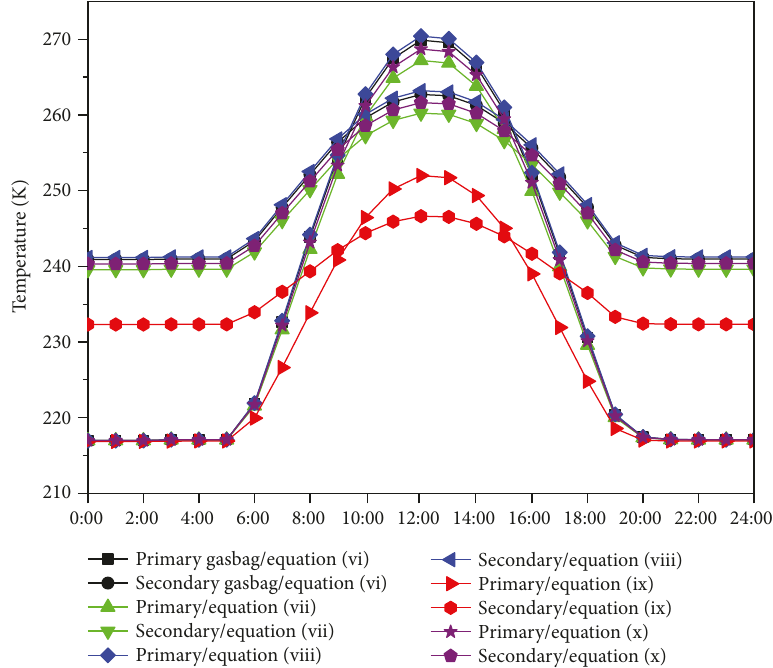
Figure 7: Helium bag temperatures calculated by di ff erent forced convection equations.